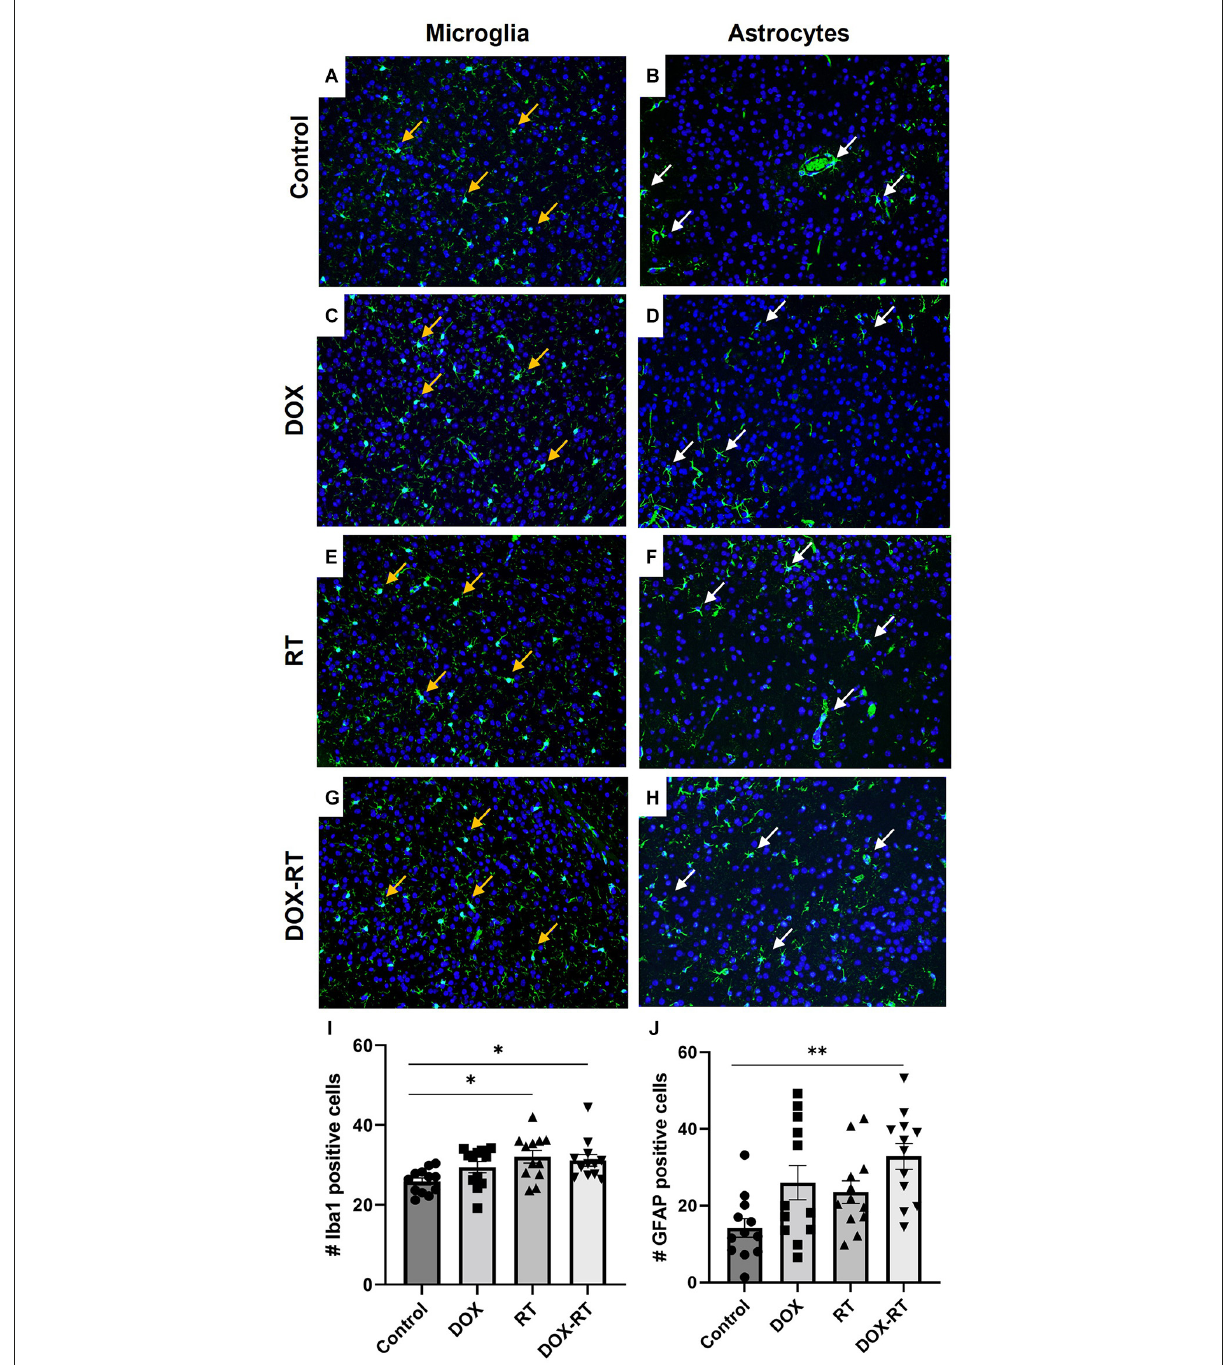
FIGURE3 Cancer therapy causes microgliosis and astrocytosis in the caudal cortex. (A–H) Iba1+ microglia (A,C,E,G) are identified with orange arrows and GFAP+ astrocytes (B,D,F,H) are highlighted with white arrows. Representative images depict microglia and astrocytes from the caudal cortex in control mice (A,B) and mice treated with DOX (C,D) , RT (E,F) or DOX-RT (G,H) . Images shown are at 200 × magnification. (I) Bar graph of Iba1+ microglia across treatment groups. Data represent the mean and SEM evaluated from four to five consecutive images per mouse ( n = 12 per group). Mice treated with RT or DOX-RT had significantly more Iba1+ microglia compared to control mice. (J) Bar graph of GFAP+ astrocytes across treatment groups. Data represent the mean and SEM evaluated from four to five consecutive images per mouse ( n = 12 per group). Mice treated with DOX-RT had significantly more GFAP+ astrocytes compared to control mice. DOX, doxorubicin group; RT, hindlimb radiation group; DOX-RT, doxorubicin and hindlimb radiation group. One asterisk ( ∗ ) representing p -value < 0.05 and two asterisks ( ∗∗ ) representing p -value <